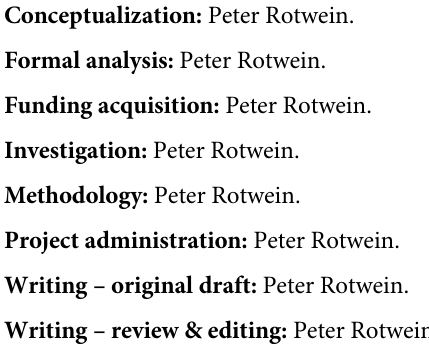
S1 Table. RNA-sequencing libraries screened for gene expression. S2 Table. Probes for screening RNA-sequencing